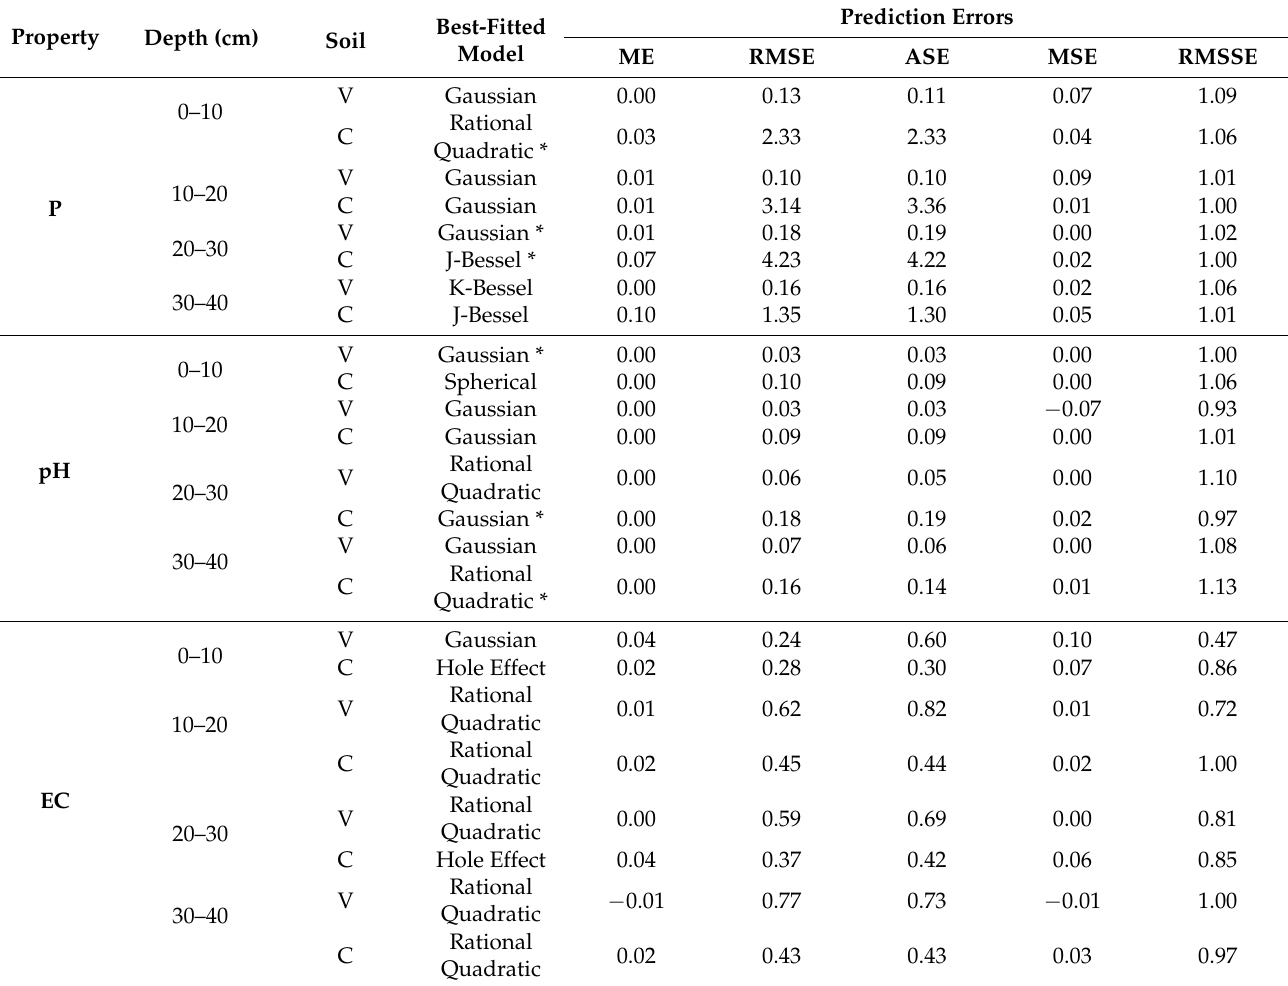
Table 3. The best-fitted models and their prediction errors for the selected soil